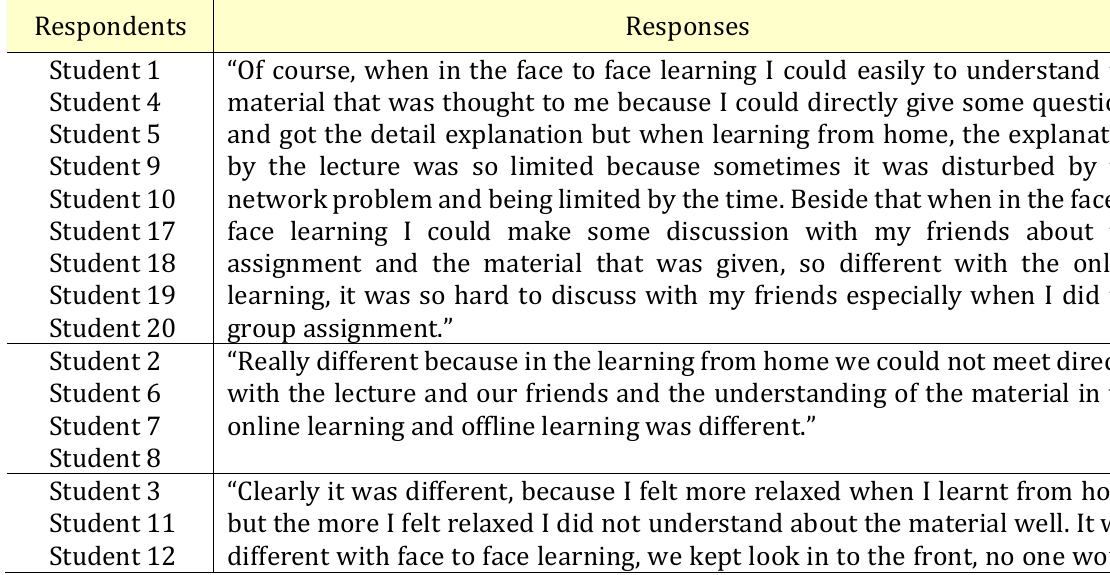
Table 5. Students from the 5th semester of English Education’s response